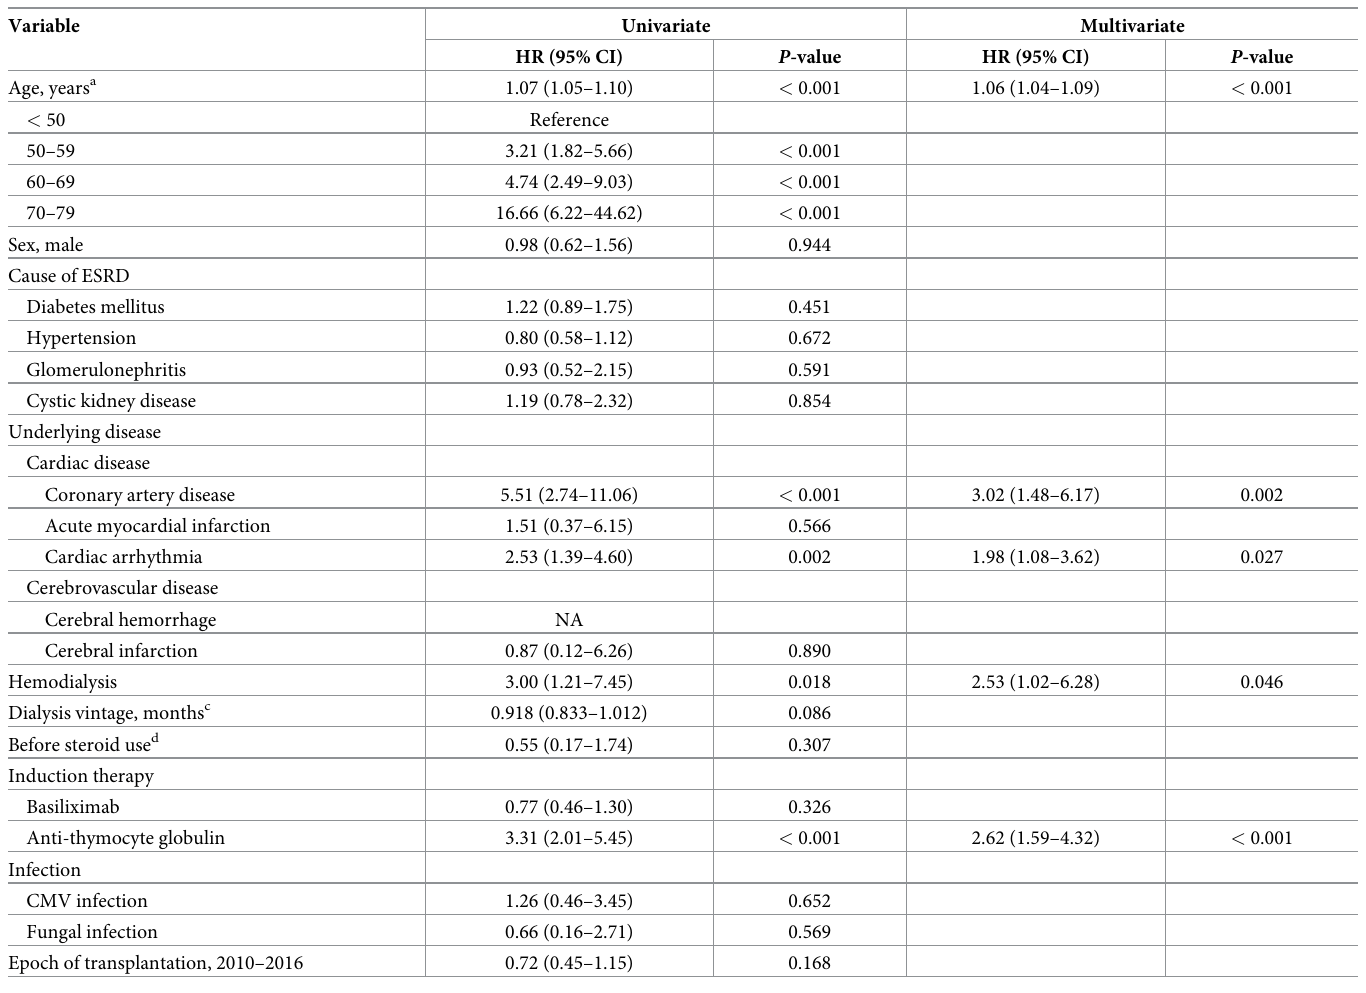
Table 2. Univariate and multivariate analyses of 1-month mortality after kidney